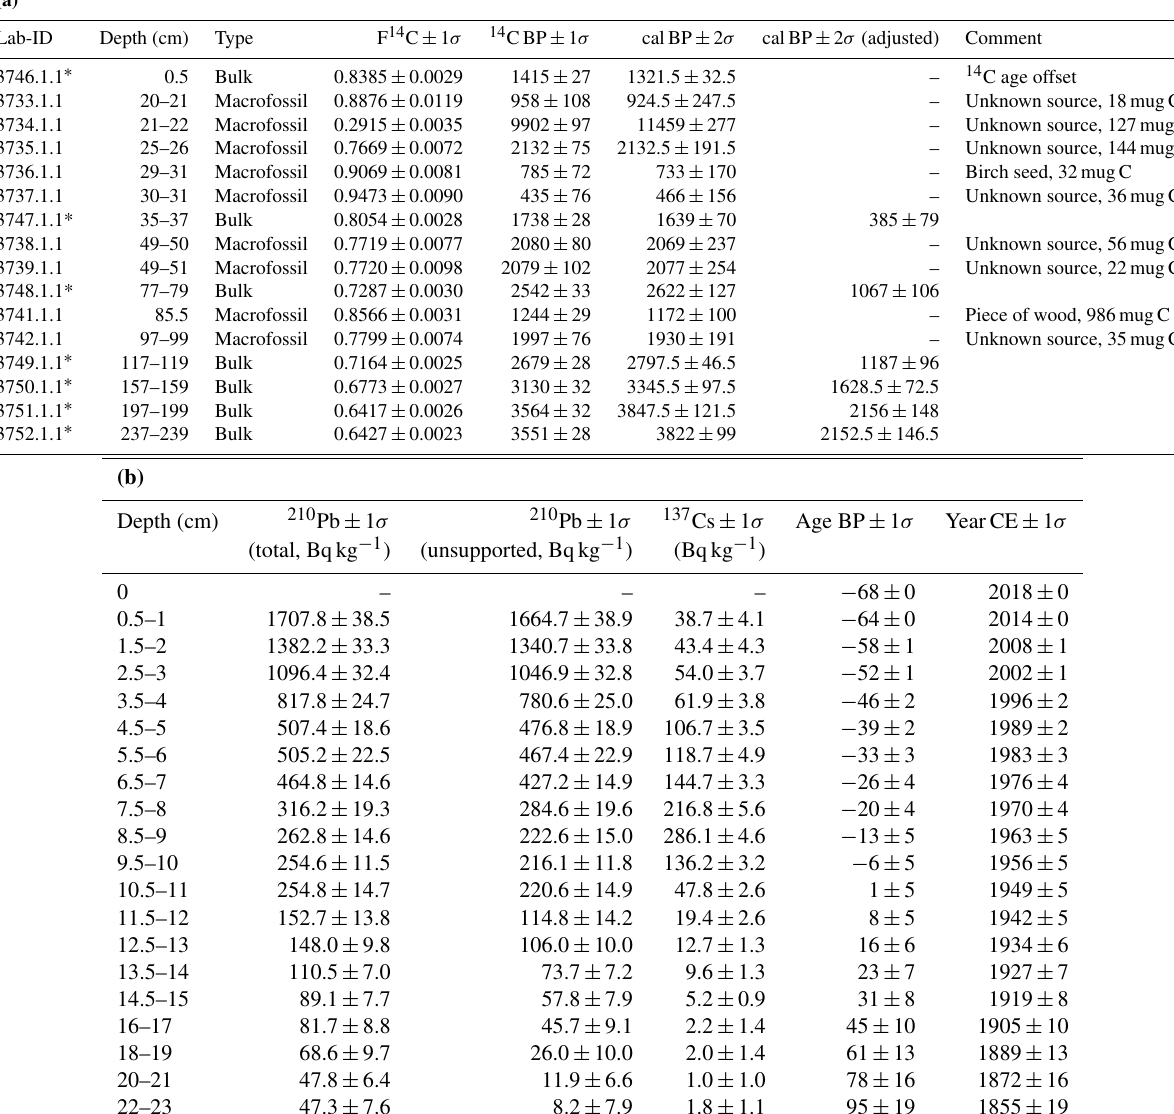
Table 1. (a) 14 C age results of bulk and macrofossil samples from core EN18232-3. All samples used for the chronology are marked with a ∗ in the first column. Lab-IDs 3732.1.1, 3740.1.1, 3743.1.1, 3743.2.1, 3745.1.1, and 3753.1.1 (not shown) belong to the six macrofossil samples that are too small to be successfully dated. (b) Pb / Cs age results from parallel short core EN18232-2 (analysed by Peter Appleby, personal communication,